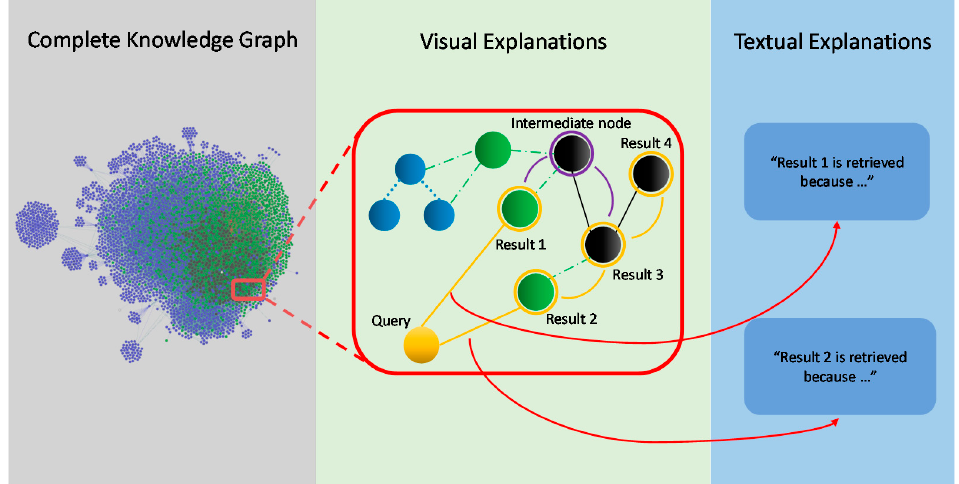
Figure 3. Visual and textual explanations based on the knowledge graph. Results that are retrieved by the IR algorithm are extracted from the graph and shown visually as a sub-graph, which shows the interlinks between different results. Textual explanations are generated from the reasoning behind linking two or more nodes in the graph to each other.